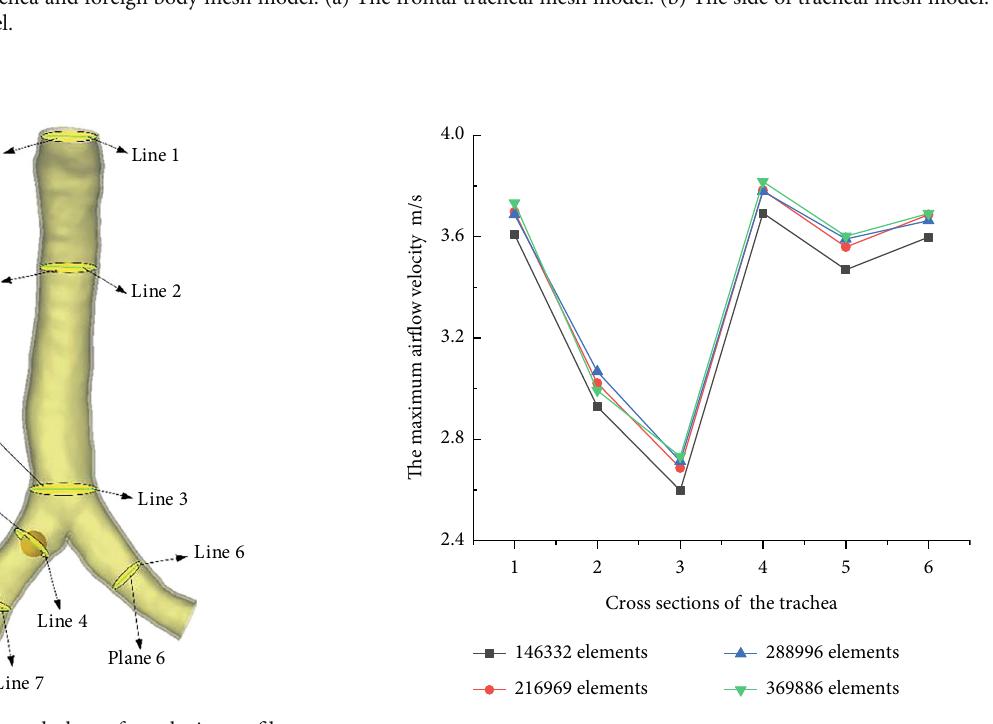
Figure 4: Grid independence veri fi cation.